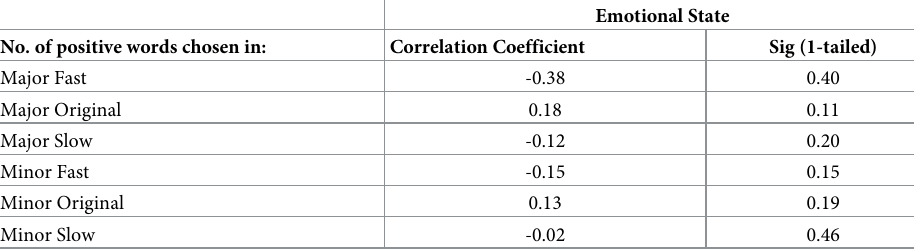
Table 1. Spearman’s correlation coefficient of emotional state and positive words selected.